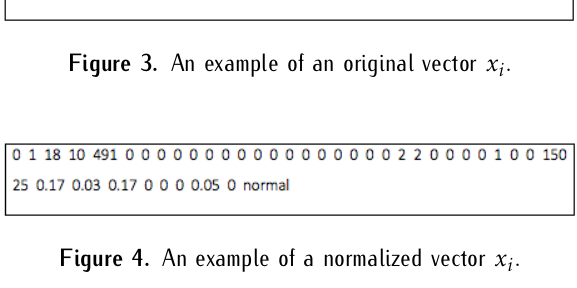
Figure 4. An example of a normalized vector x